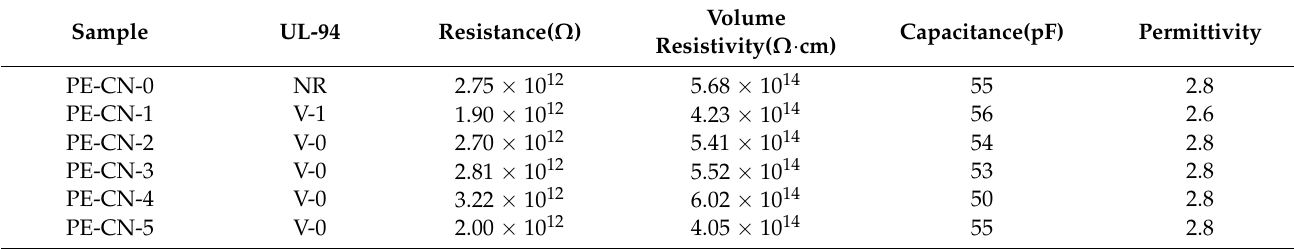
Table 2. UL-94 vertical burning level and insulation properties of PE-CN